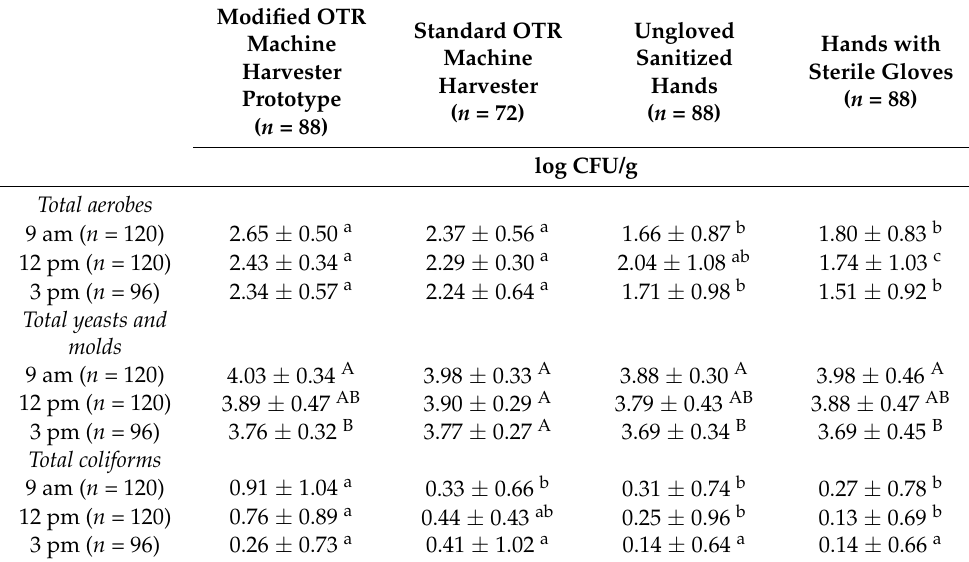
Table 3. Microbial load on sampled fresh blueberries harvested using different methods at individual sampling time